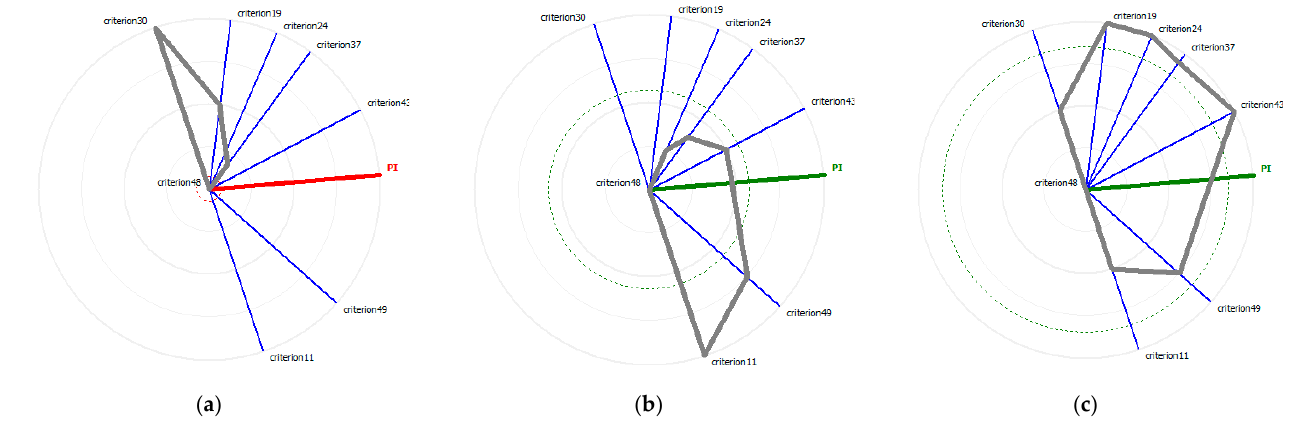
Figure 7. GAIA web results: ( a ) Alternative_01; ( b ) Alternative_02; ( c ) Alternative_03.